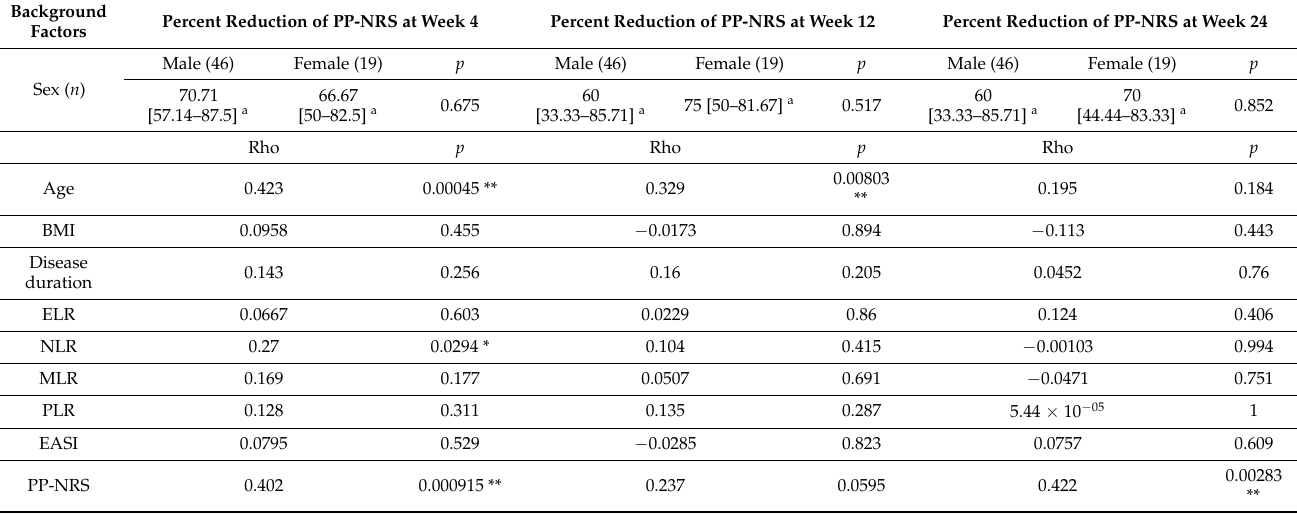
Table 6. The relations of patients’ background factors with the percent reduction of the peak pruritus- numerical rating scale (PP-NRS) at weeks 4, 12, or 24 of upadacitinib treatment for patients with atopic dermatitis ( n =